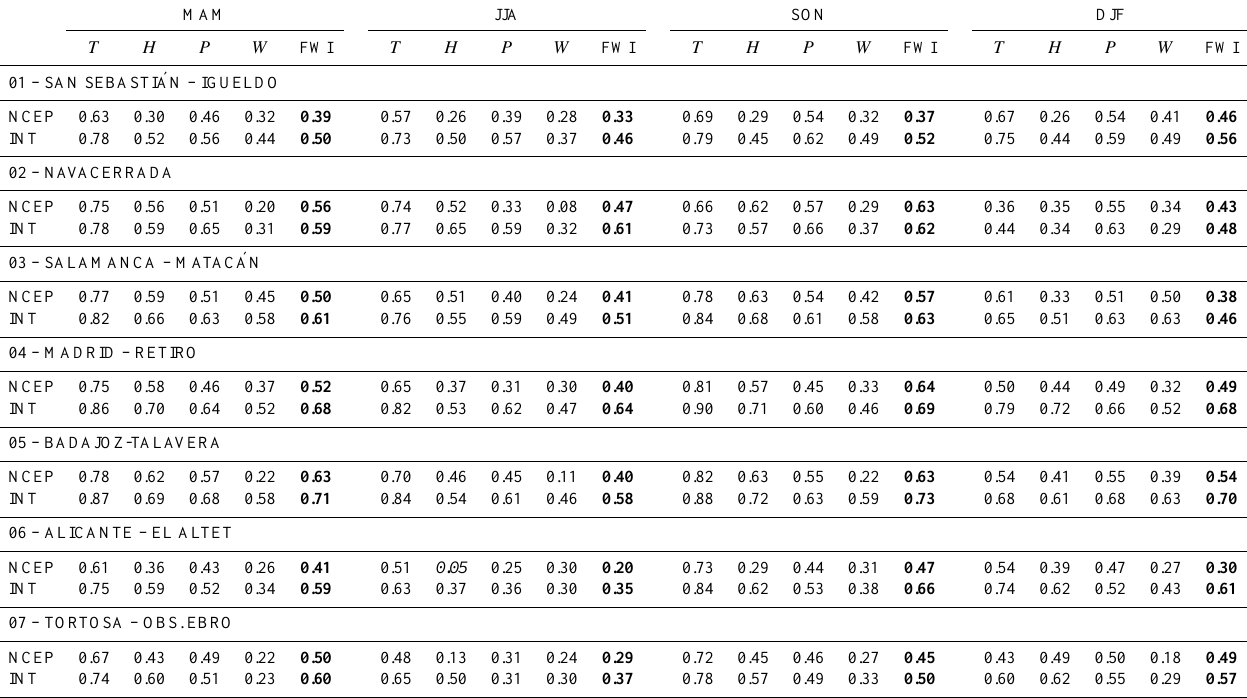
Table 3. Correlation coefficients (Mann-Kendall’s Tau) between observations of the AEMET stations network (Table 2) and the NCEP and ERA-Interim reanalyses for the variables mean surface temperature ( T ), relative humidity ( H ), precipitation ( P ) and wind velocity ( W ), grouped by seasons (MAM = Spring, March, April, May; JJA = Summer, June, July, August; SON = Fall, September, October, November; DFJ = Winter, December, January, February). The correlation of the derived fire weather index (FWI) is also indicated. Non-significant correlations are written in italics ( p > 0 .